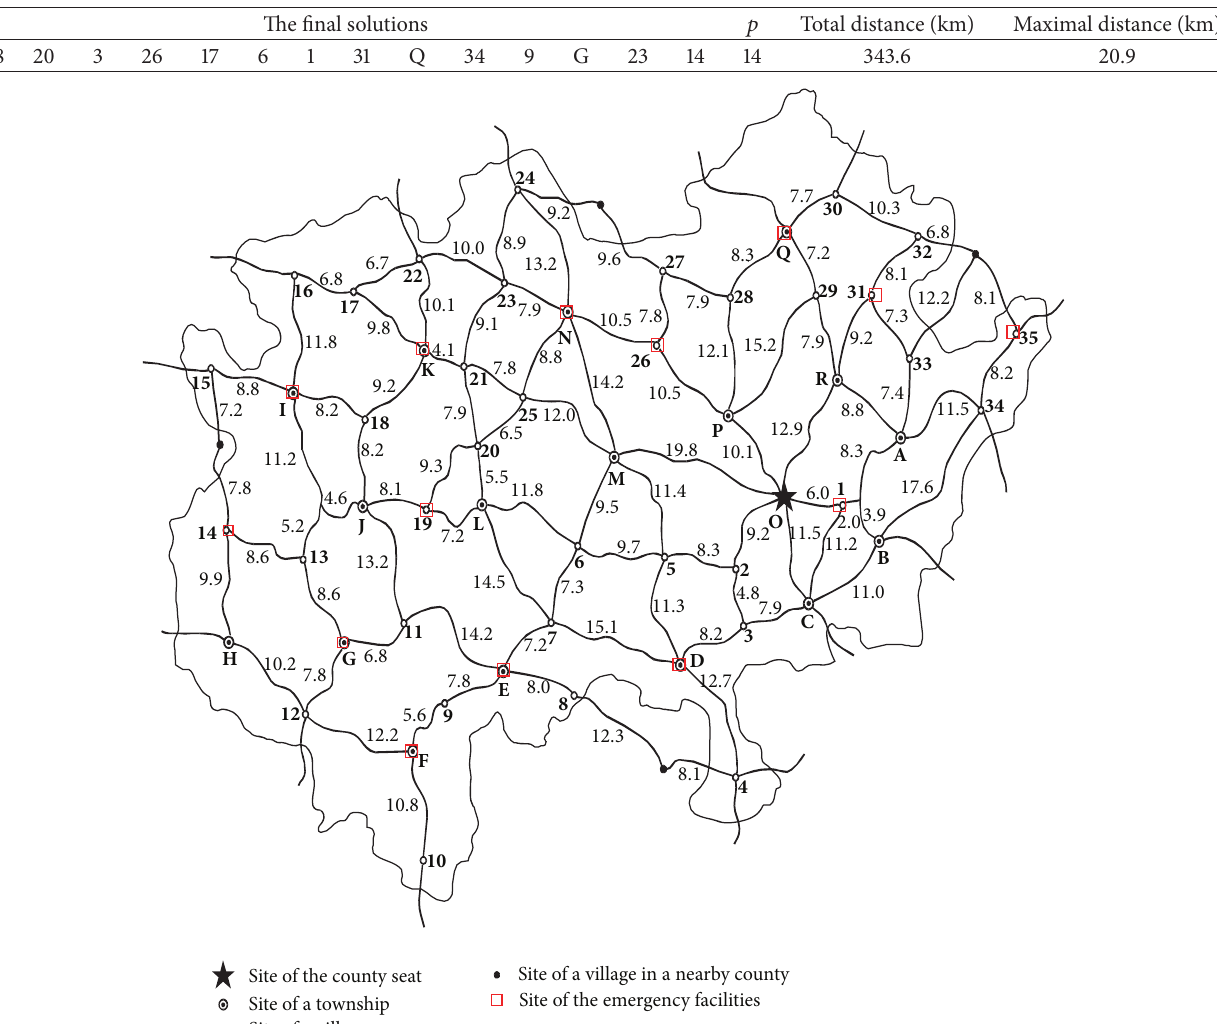
Figure 2: Locations of the emergency facilities in the case study with maximum time